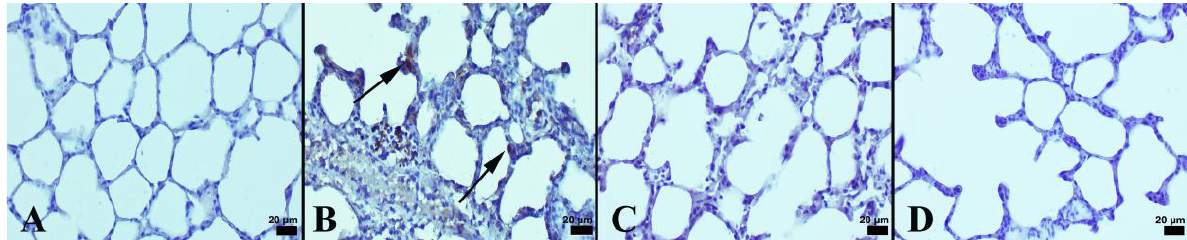
Figure 3. ICAM-1 expressions between the groups: ( A ) negative expression in control group; ( B ) increased expression (arrows) in alveolar cells (arrows) in LPS group; ( C ) decreased expression (arrow) in LPS + NBL group; and ( D ) negative expression in NBL group, Streptavidin biotin method, scale bars = 20 µm.